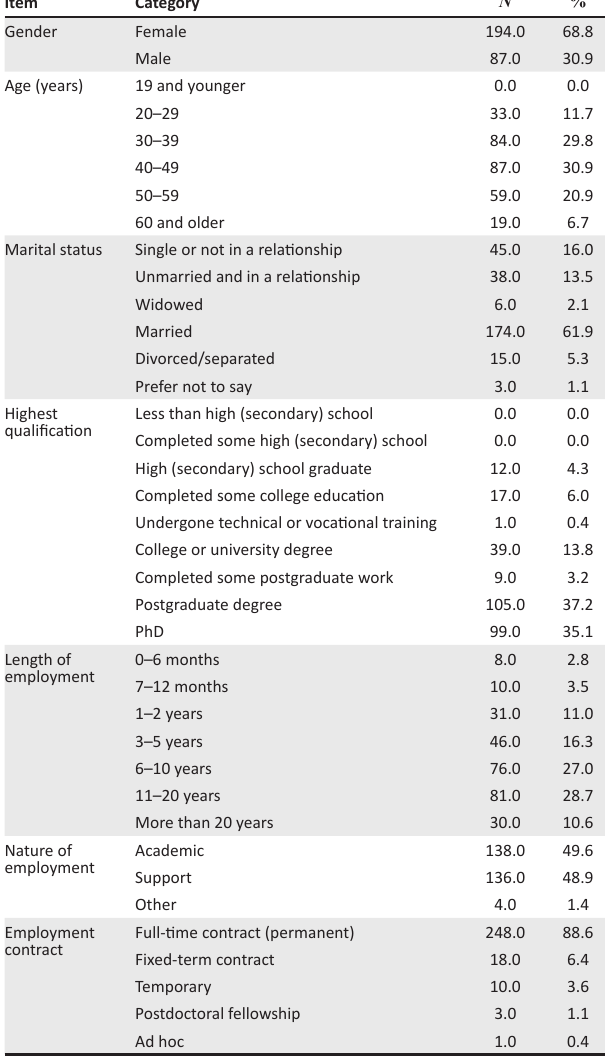
TABLE 1: Sociodemographic